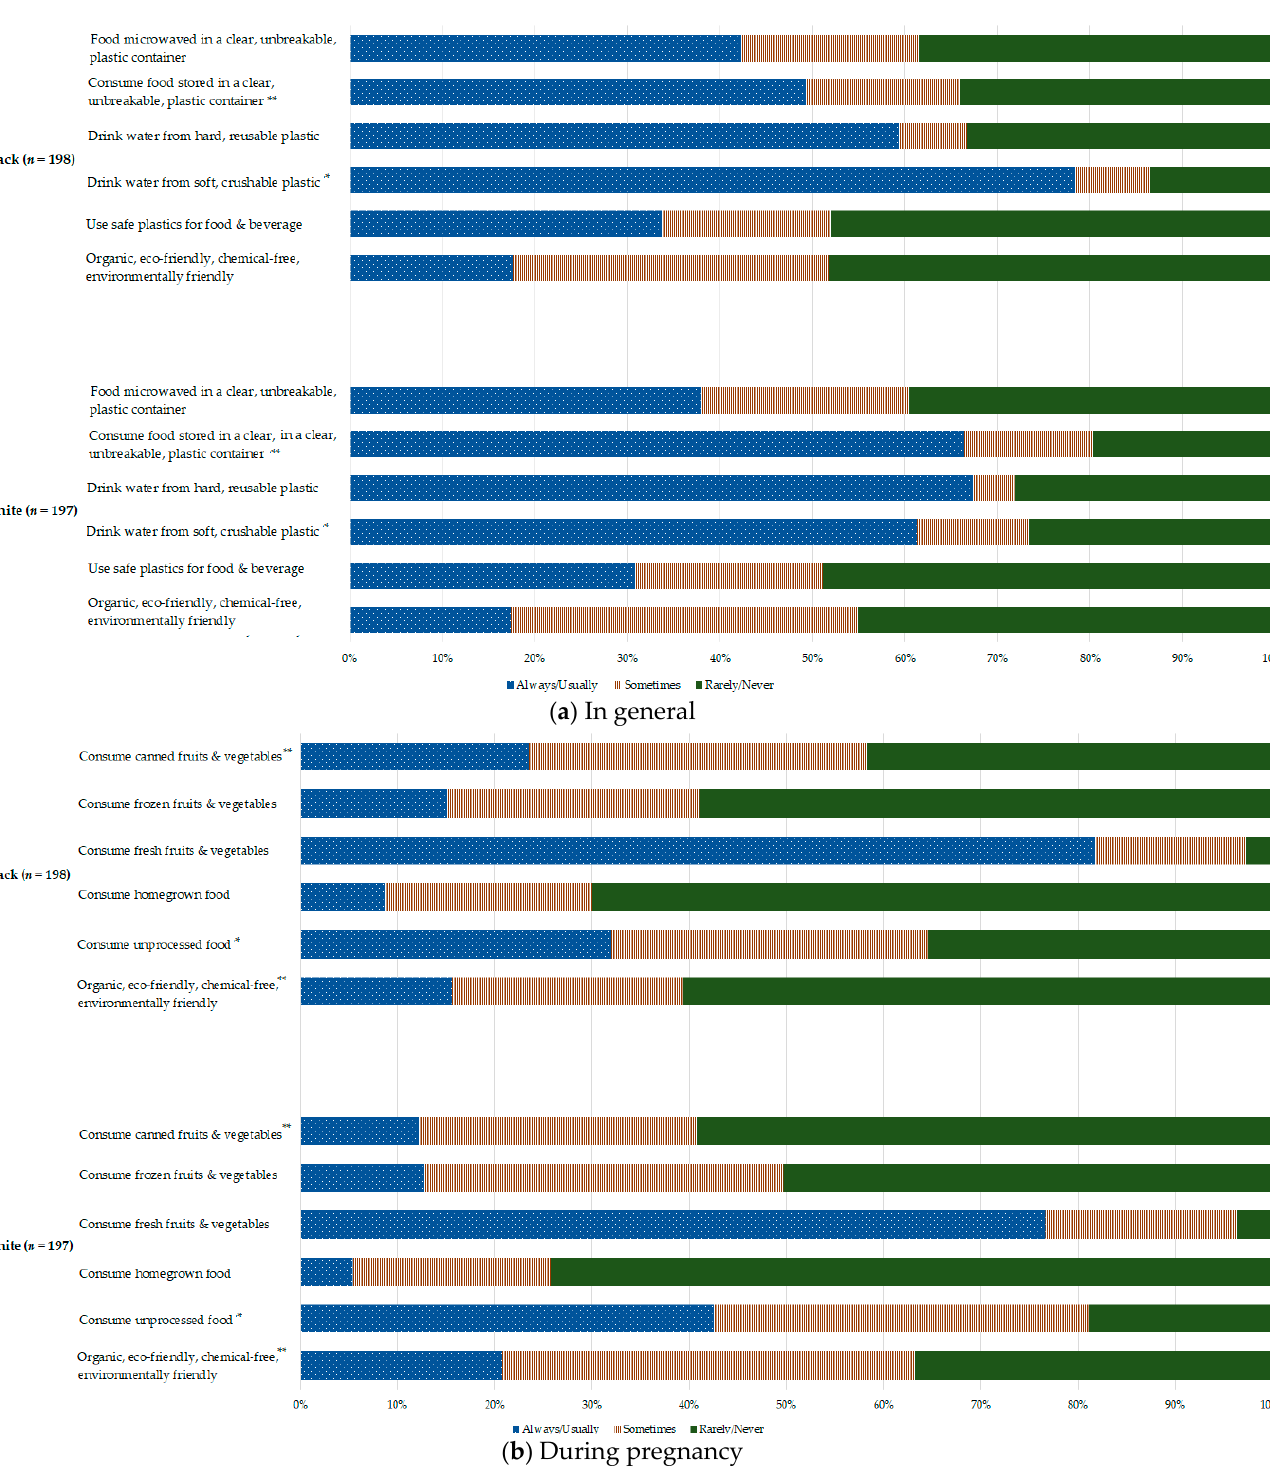
Figure 1. Distribution of food and beverage consumption habits overall and by race, in general ( a ) and during pregnancy ( b ). * p < 0.01; ** p < 0.001 for difference between races.